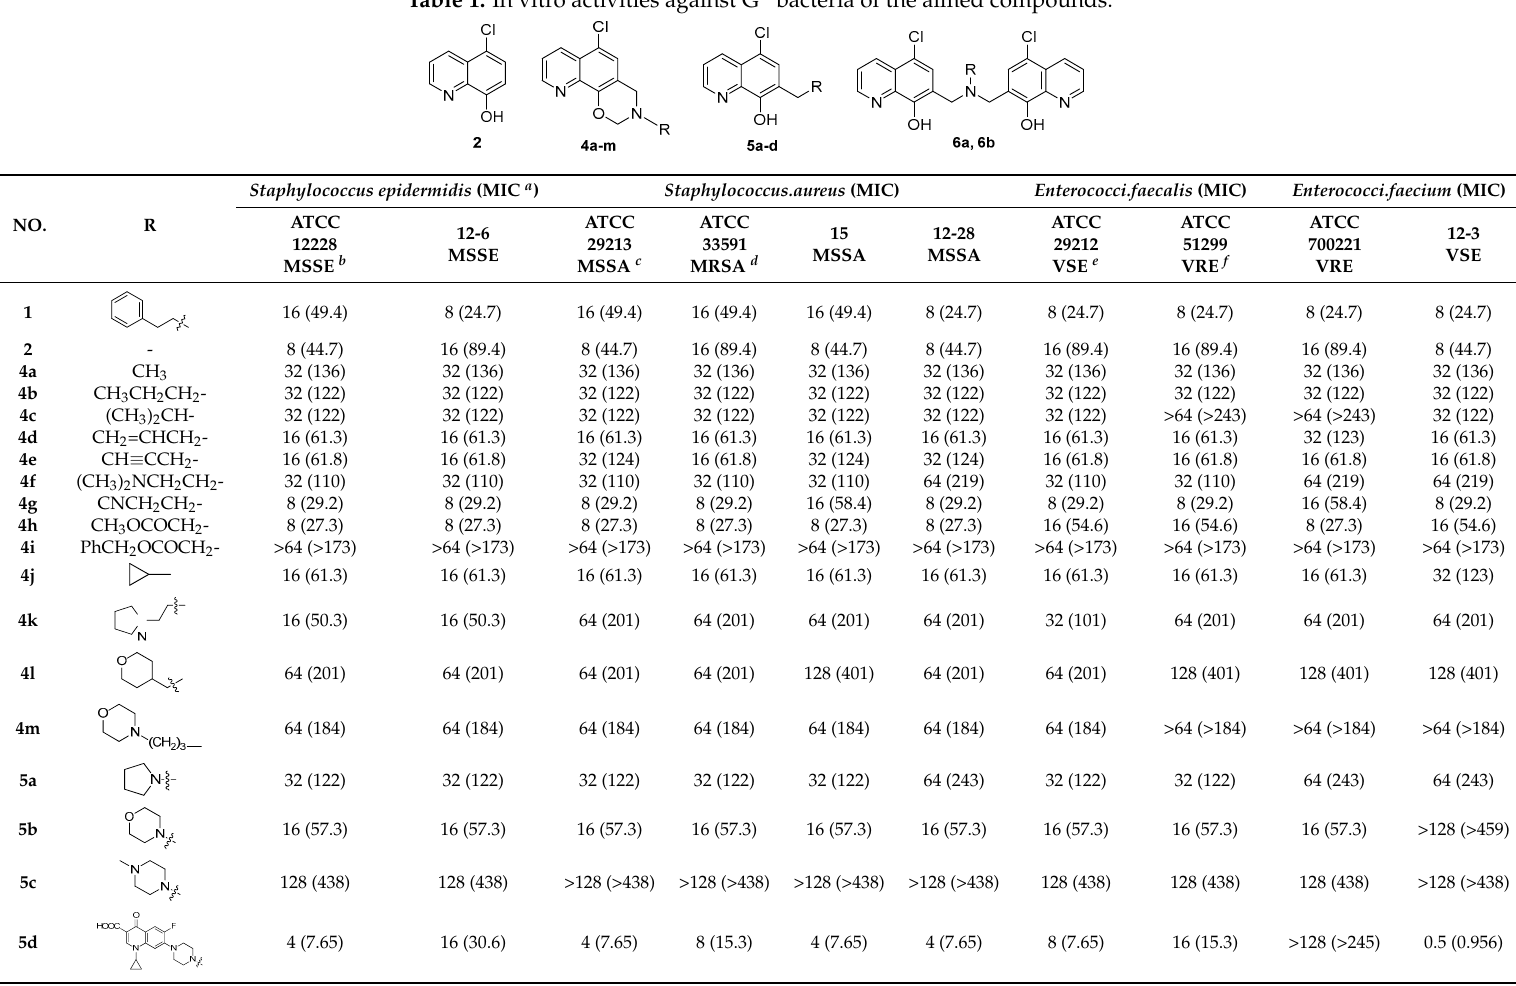
Table 1. In vitro activities against G + bacteria of the aimed compounds.